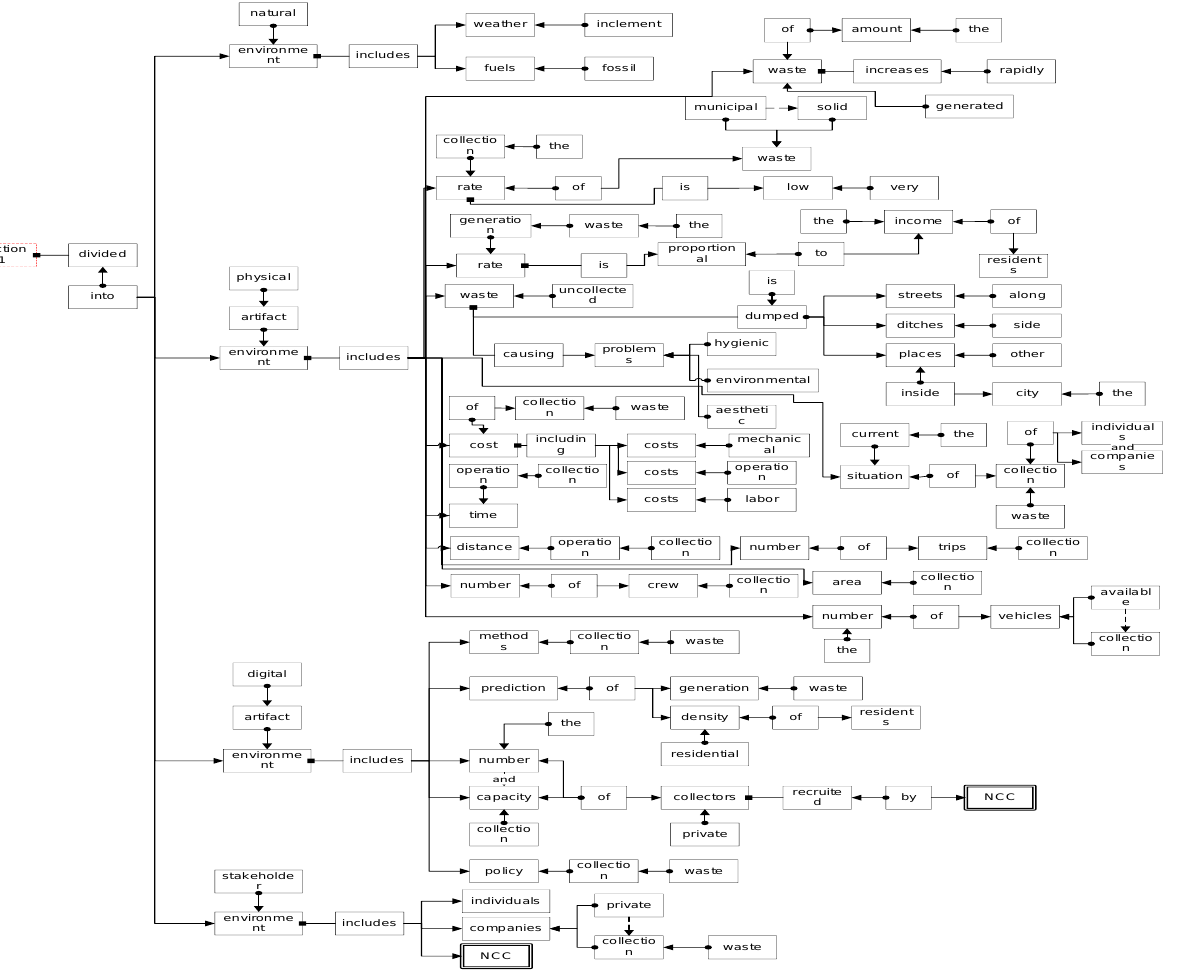
Figure 7 . Section 1 (waste collection) of Figure 6 ROM diagram.